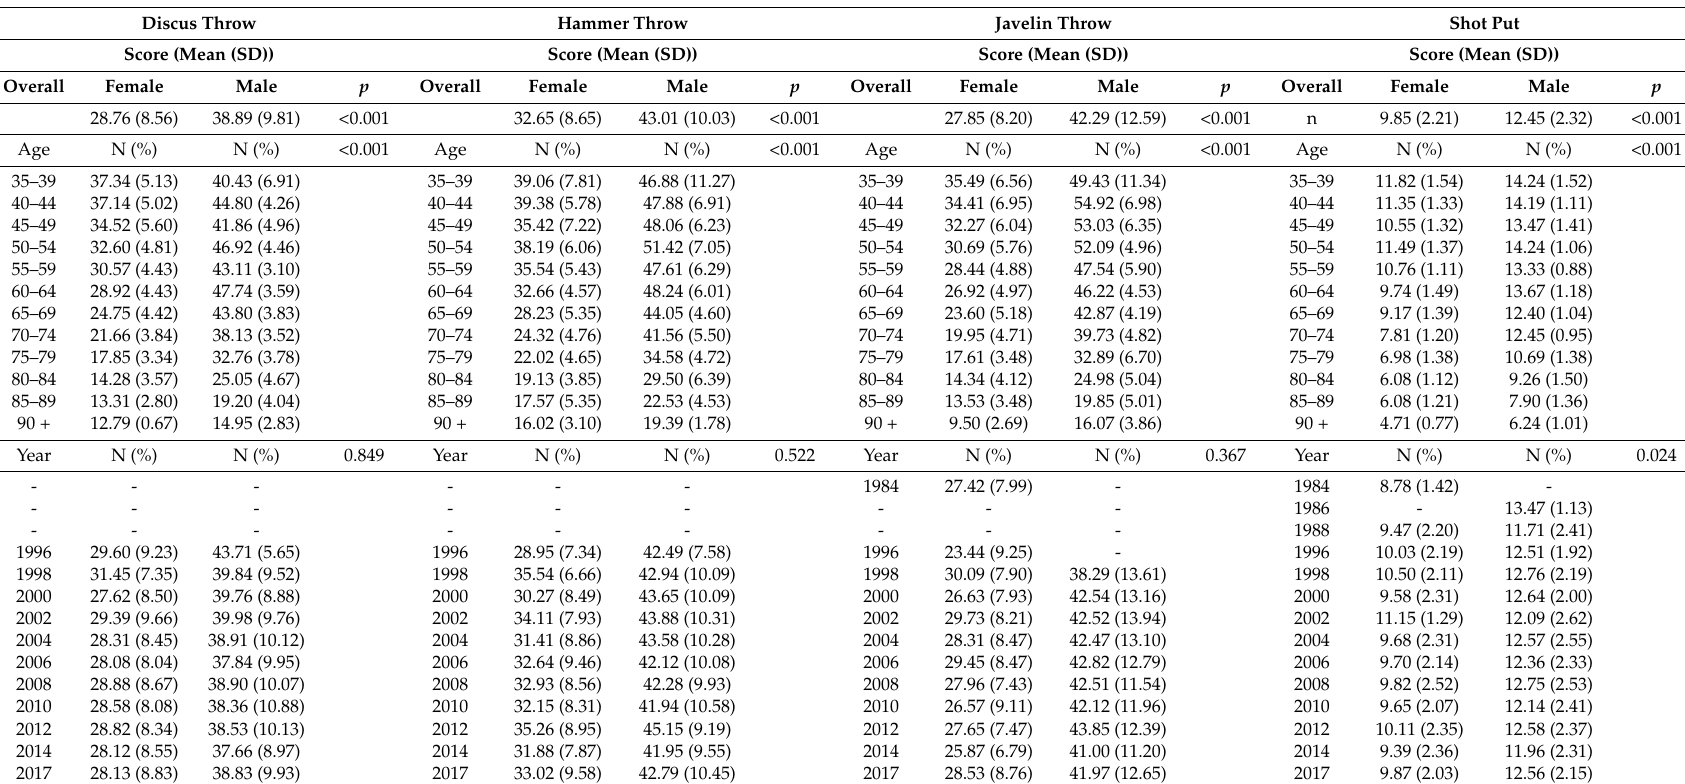
Table 1. The performance (mean) for each event by sex, overall and by age group and time. The p -values are from t -test of groups (overall) or two-way ANOVA (by age and sex/by year and sex). For jumping events, sex difference (diff) are reported in